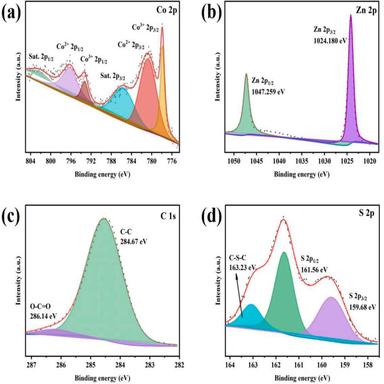
XPS spectra of the Co9S8/ZnS@C composite: (a) survey spectrum; (b) Zn 2p; (c) C 1s and (d) S 2p.